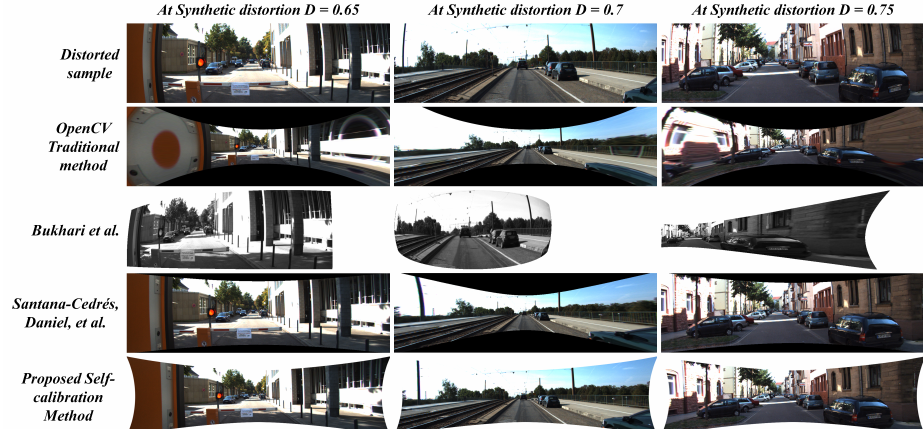
Figure 16. Comparison between proposed method against contemporary self-calibration and OpenCV traditional algorithms on Synthetically distorted KITTI data (D = 0.65 ∼ 0.75).